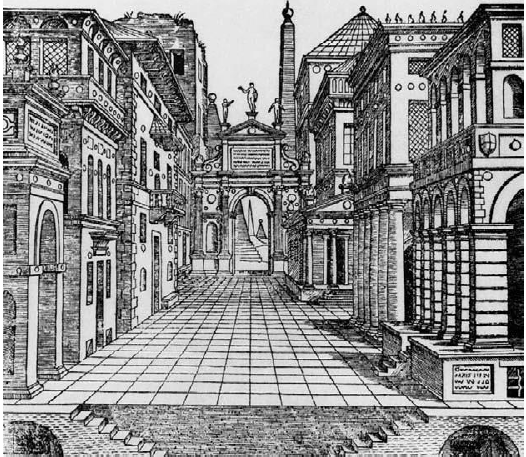
Figure 11. Objective elements of the space representing spatial quality ( Moughtin, 1992).